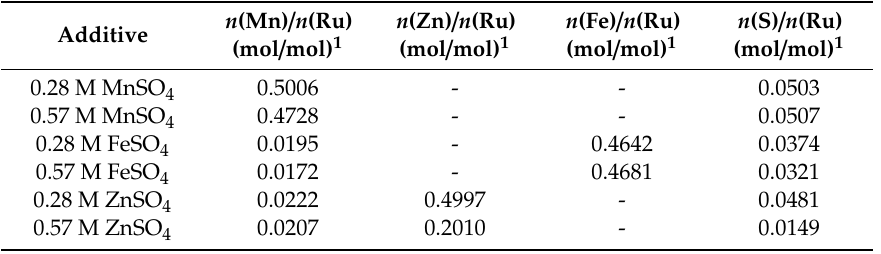
Table 3. Composition of spent Ru@Mn 3 O 4 (0.46) with applying 0.28 mol L − 1 as well as 0.57 mol L − 1 of ZnSO 4 , MnSO 4 and FeSO 4 as additives.